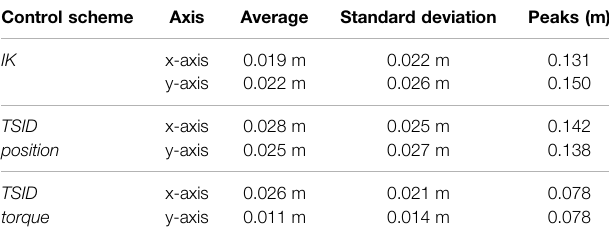
TABLE 2 | ZMP error of the 20-cm step walk